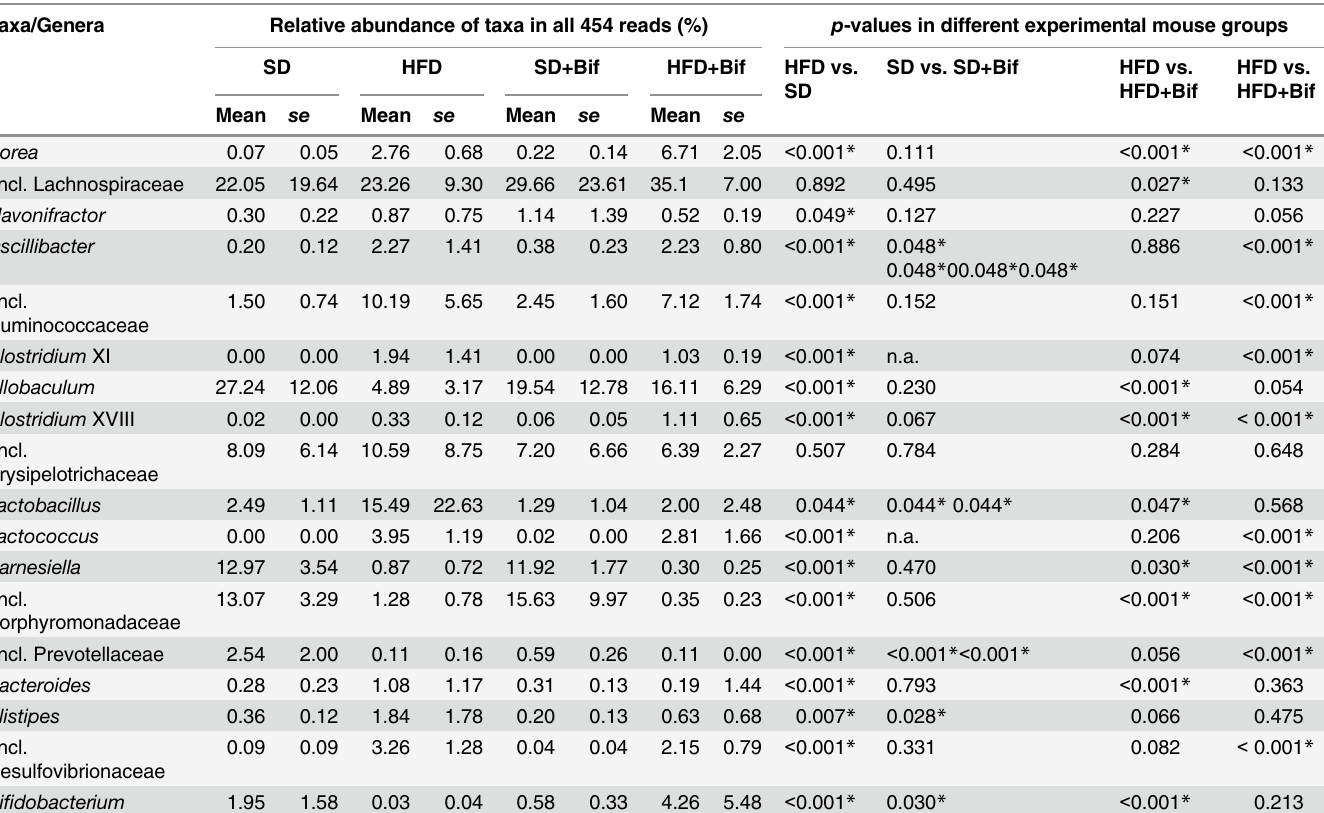
Table 3. Average abundances of bacterial taxa detected in the microbiota of different mouse groups after 14 weeks dietary intervention. Taxa/Genera Relative abundance of taxa in all 454 reads (%) p -values in different experimental mouse